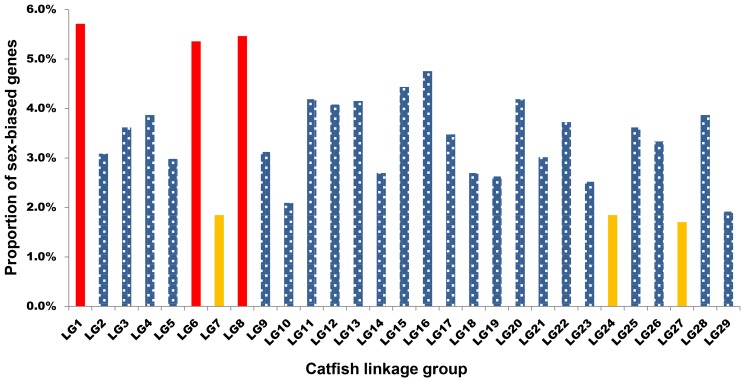
Linkage group distribution of the male-biased genes.Note that the proportion of male-biased genes per linkage group is similar except for chromosomes 1, 6, 8, 7, 24 and 27 (shown in red for linkage groups with high numbers of male-biased genes and in yellow for linkage groups with low numbers of male-biased genes).